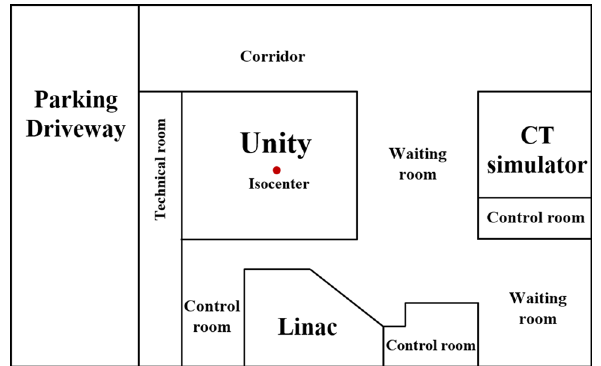
Figure 7. Location of vibration and magnetic field examination (red